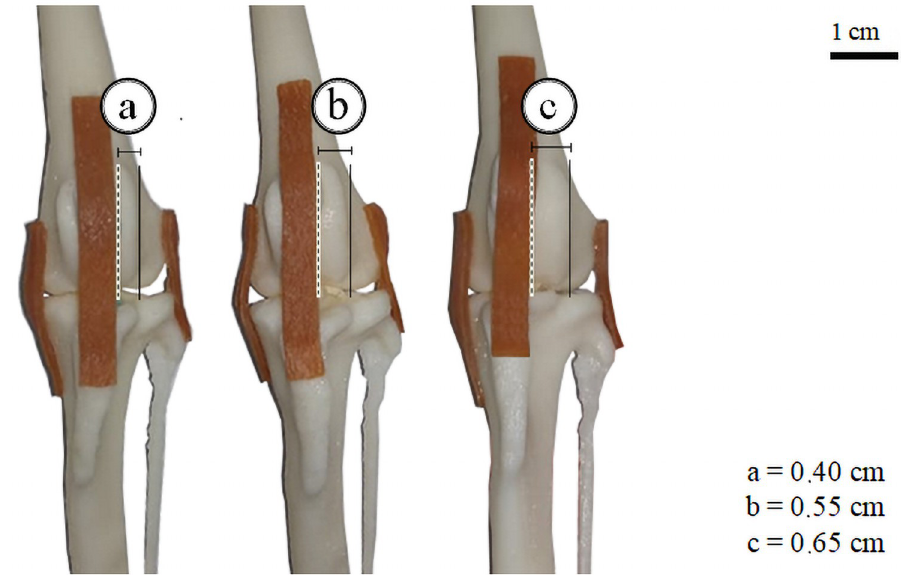
Fig 4. Three-stages of the femorotibiopatellar joint: Medial patellar luxation. (a) Healthy articulation, without morphological alterations; (b) Joint with medial rotation of tibia and its tuberosity; (c) Articulation with the rotated tibia associated with the flattening of trochlear sulcus and medial condyle. In the corner: variation of the distance as the moving line (dotted) moves away from the fixed line (continuous).